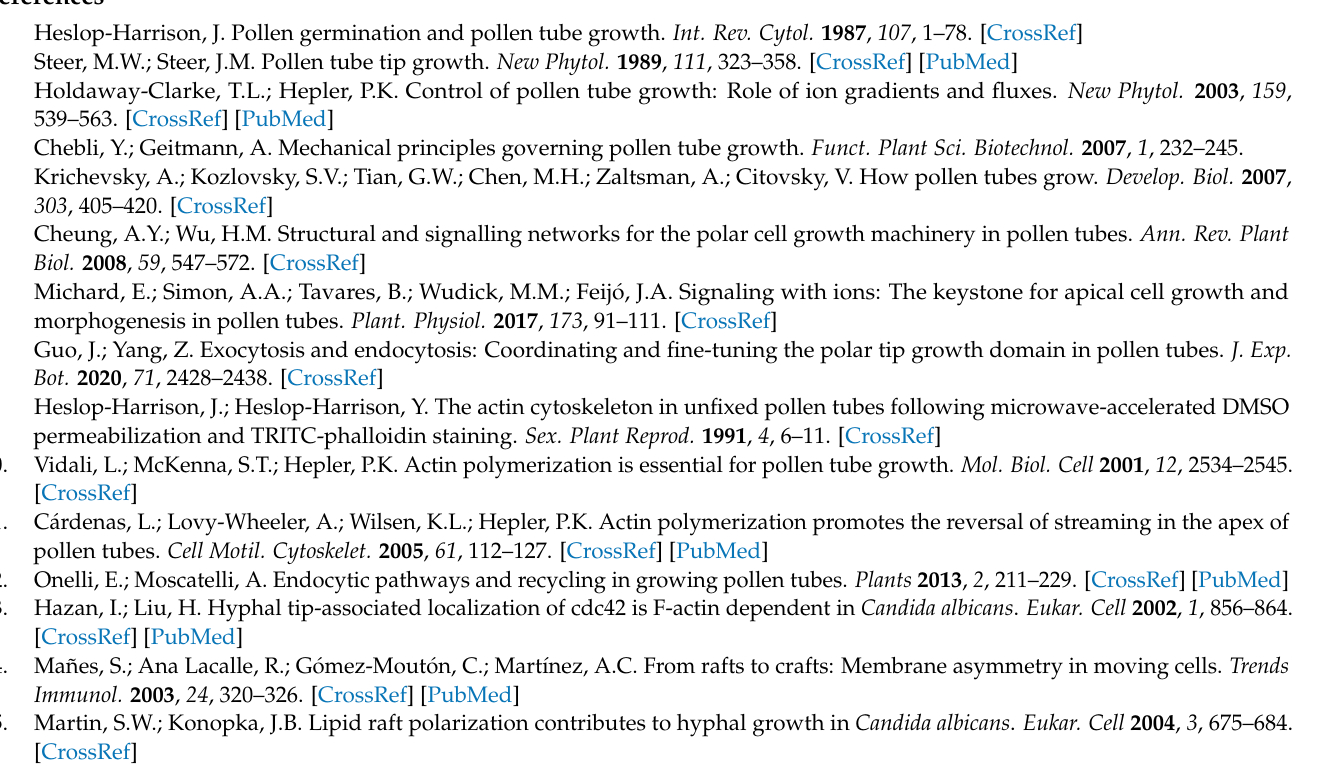
distribution. Figure S1: Filipin staining; Figure S2: pLat52-LIFEACT-EGFP overexpressed pollen tubes; Figure S3: Effect of Myriocin and Squalestatin on LEP